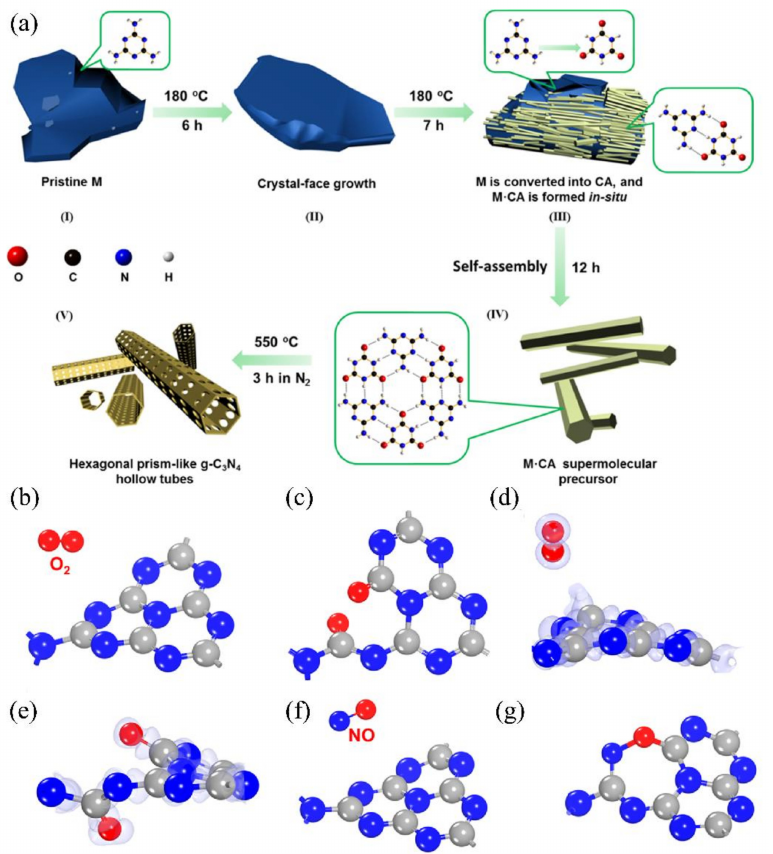
Figure 10. ( a ) Schematic illustration for the preparation of nitrogen vacancies − mediated g − C 3 N 4 microtubes. ( b – g ) Schematic illustration for the nitrogen vacancies in g − C 3 N 4 photocatalysts for the enhanced adsorption behavior [109]. Copyright 2019. American Chemical